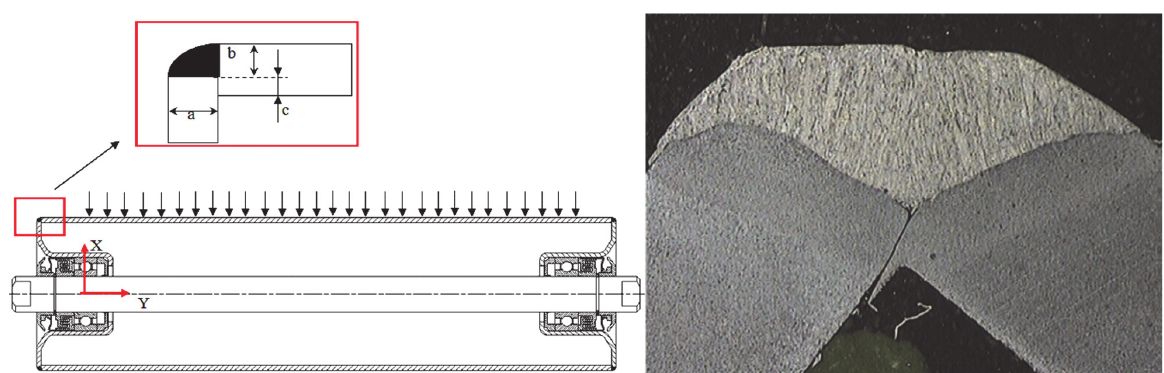
Figure 1: Scheme showing the main geometrical parameters at the weld root and an example of lack of penetration. - Two bearing housing made by a steel monolithic structure (in agreement with UNI EN 10111 characterized by a yield strength 170< σ y <330 MPa), deep drawn and sized to a forced fixed tolerance (ISO M7) at the bearing position. The thickness of the housings is proportional to the spindle diameter and to the bearing type, with thicknesses that are up to 5 mm, to guarantee the maximum strength for each application, including the